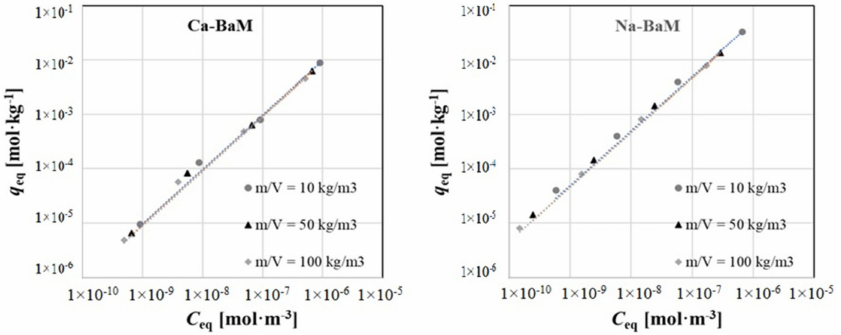
Figure 4. Sorption isotherms of Sr on the bentonite Ca-BaM in CaCl 2 background electrolyte ( left ) and on the bentonite Na-BaM in NaCl background electrolyte ( right